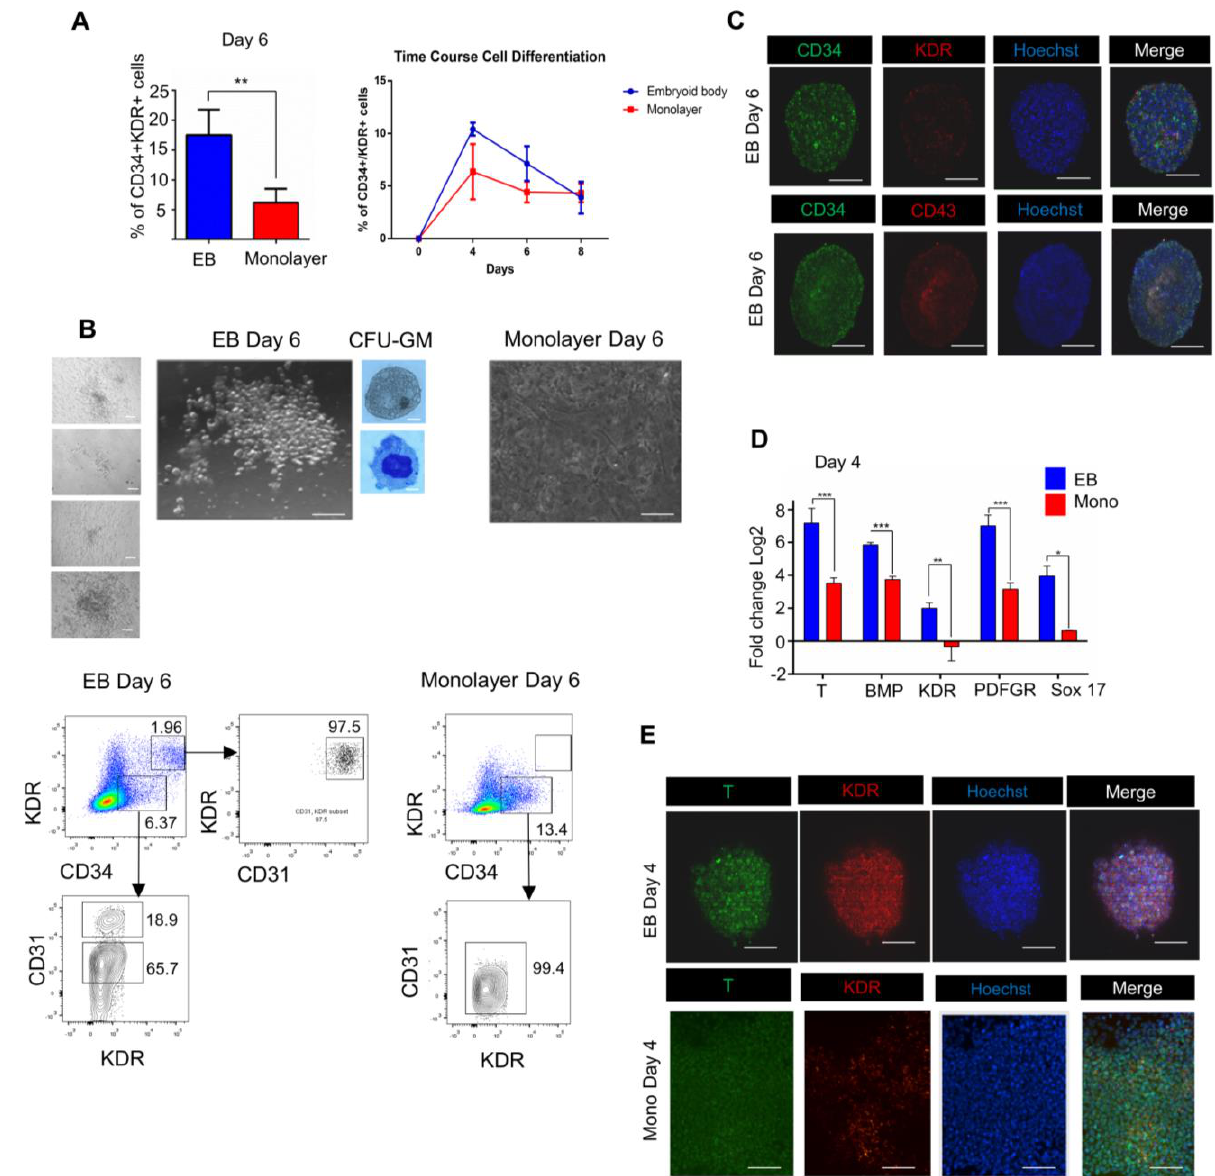
Figure 3. 3D/EB suspension and 2D/monolayer formats differ significantly in their capability of producing hematopoietic cells from hPSCs. ( A ) Comparison of the percentages of the cells with CD34+/KDR phenotype generated by the 3D and 2D systems on day 6 (Mean ± SEM) n = 4, ** p ≤ 0.01. Time course of CD34/KDR cells in 3D and 2D formats ( B ) Phase contrast image of hematopoietic colonies in methylcellulose shown for 3D/EB on day 30 after Wright-Staining (see methods), showing images of a typical macrophage and a monocyte. No such cells were present in the 2D system. Flow